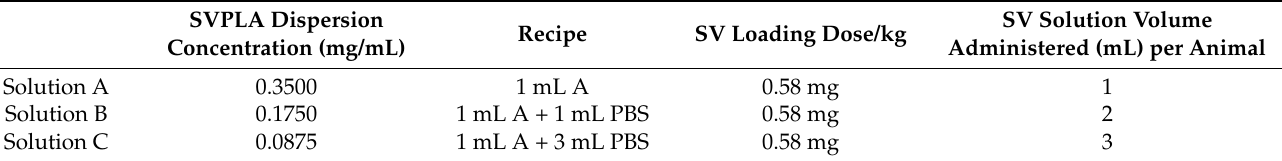
Table 5. SVPLA particles dispersion characteristics used in biological